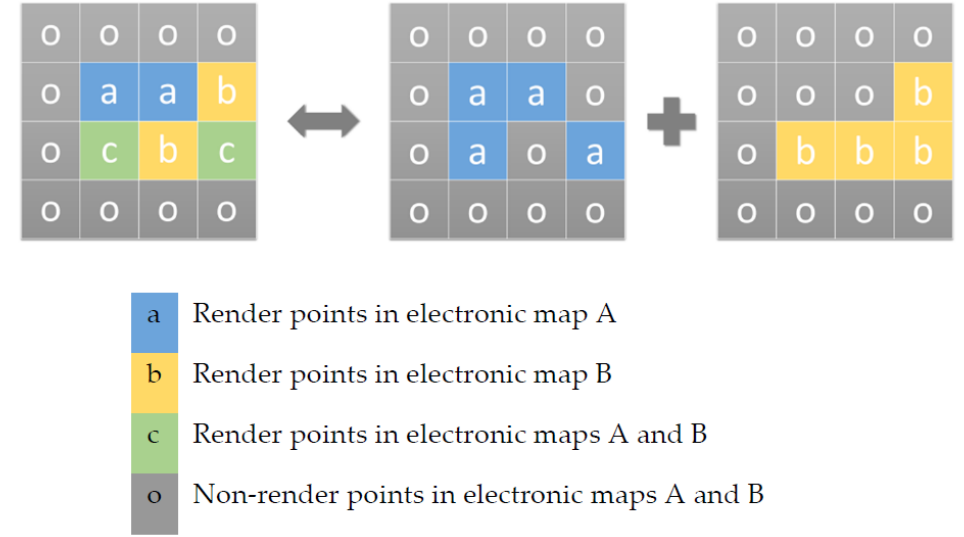
Figure 2. An example of using a rendering matrix of high-speed road features in a scenario where two types of electronic maps, map A and map B, are generated. The left side of the equivalence symbol is the render matrix, which uses di ff erent letters to encode the rendering information of the highways in maps A and B. The right side of the equivalence symbol is the equivalent expression of the rendering matrix, which reflects the rendering information of the highways in maps A and B obtained from the rendering matrix.